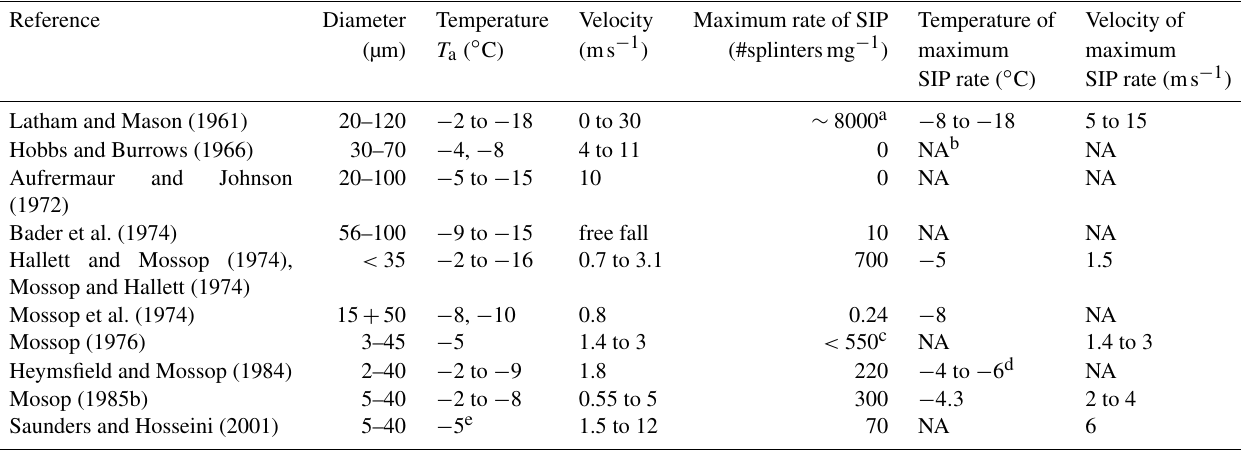
Table 2. Summary of experimental studies of rime splintering (HM process). The table covers only works that quantified the parameters included in the